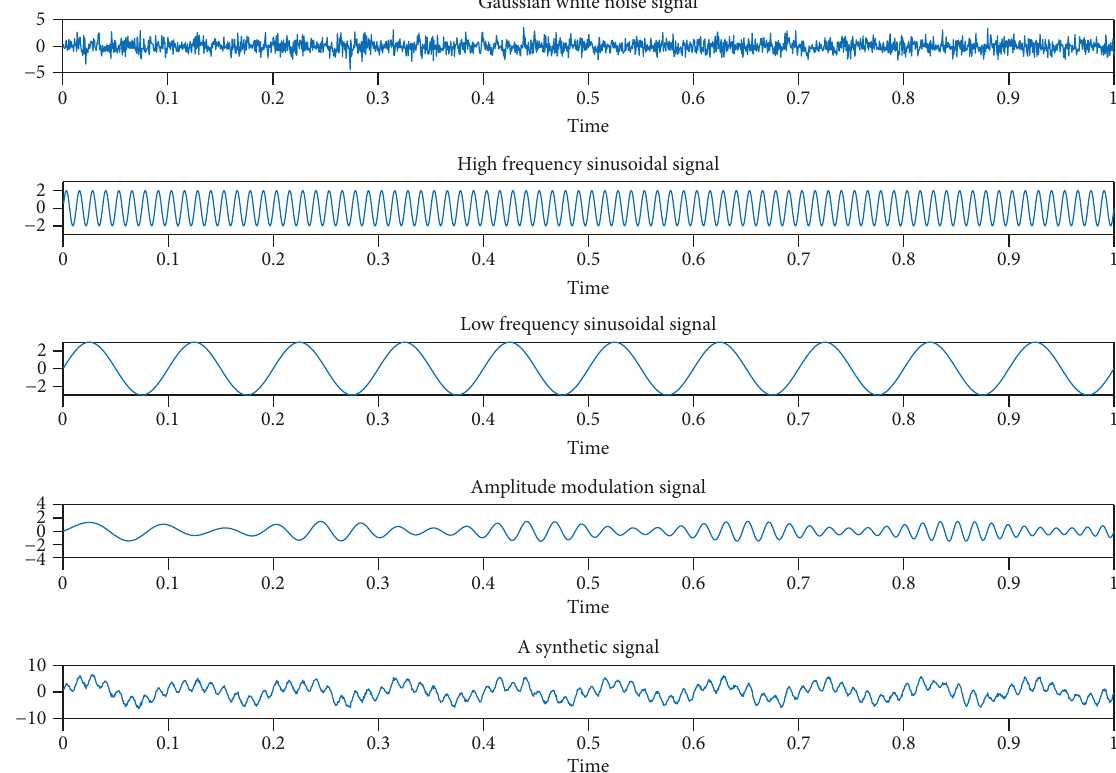
Figure 2: A synthetic signal S